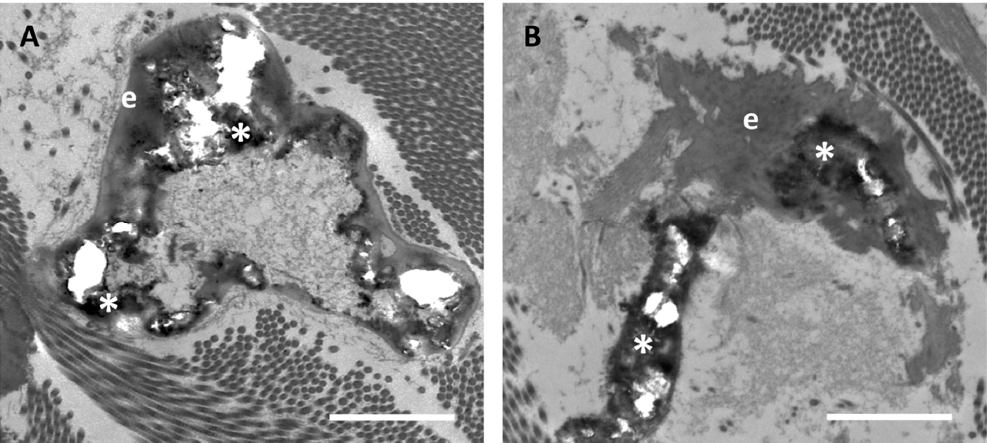
Figure 1. Representative electron microscopy images of calcified elastic fibers which are very rarely observed in clinically unaffected skin ( A ), whereas are highly abundant in the affected ( B ) skin in the same PXE patient. When present, calcification is characterized by electron-dense mineral deposits (asterisk *) altering the elastin amorphous structure (e). Scale bar = 1 µm.